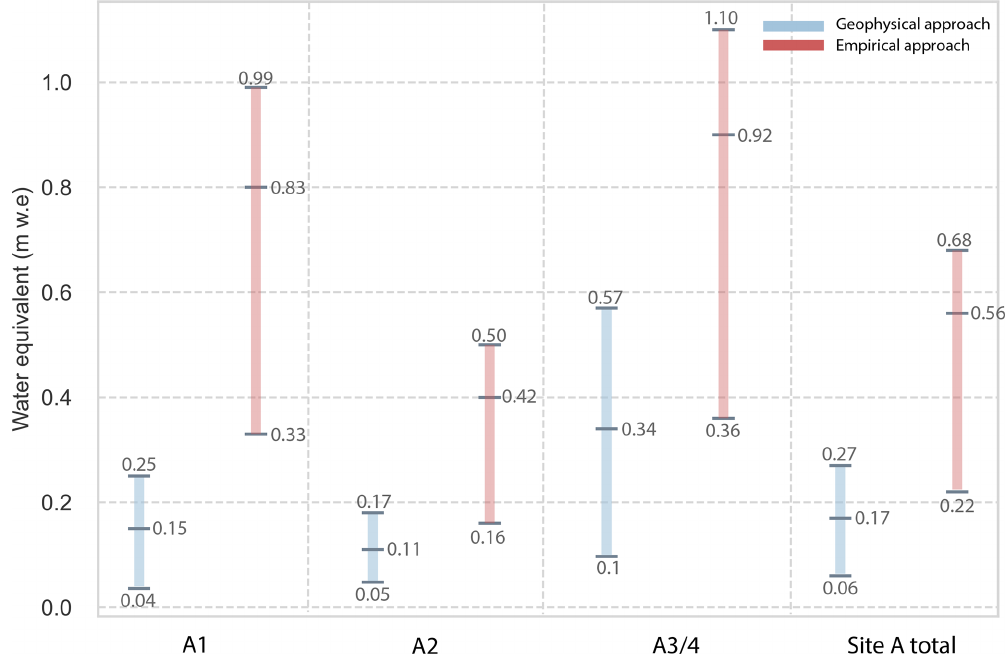
Figure 9. Comparison of water equivalent (mw.e.) estimations for Site A, scenario SA1 (considering only rock glaciers as ice-bearing class), for (i) the geophysically based upscaling technique (blue bars) presented in this paper and (ii) the empirical rule (red bars) introduced by Brenning